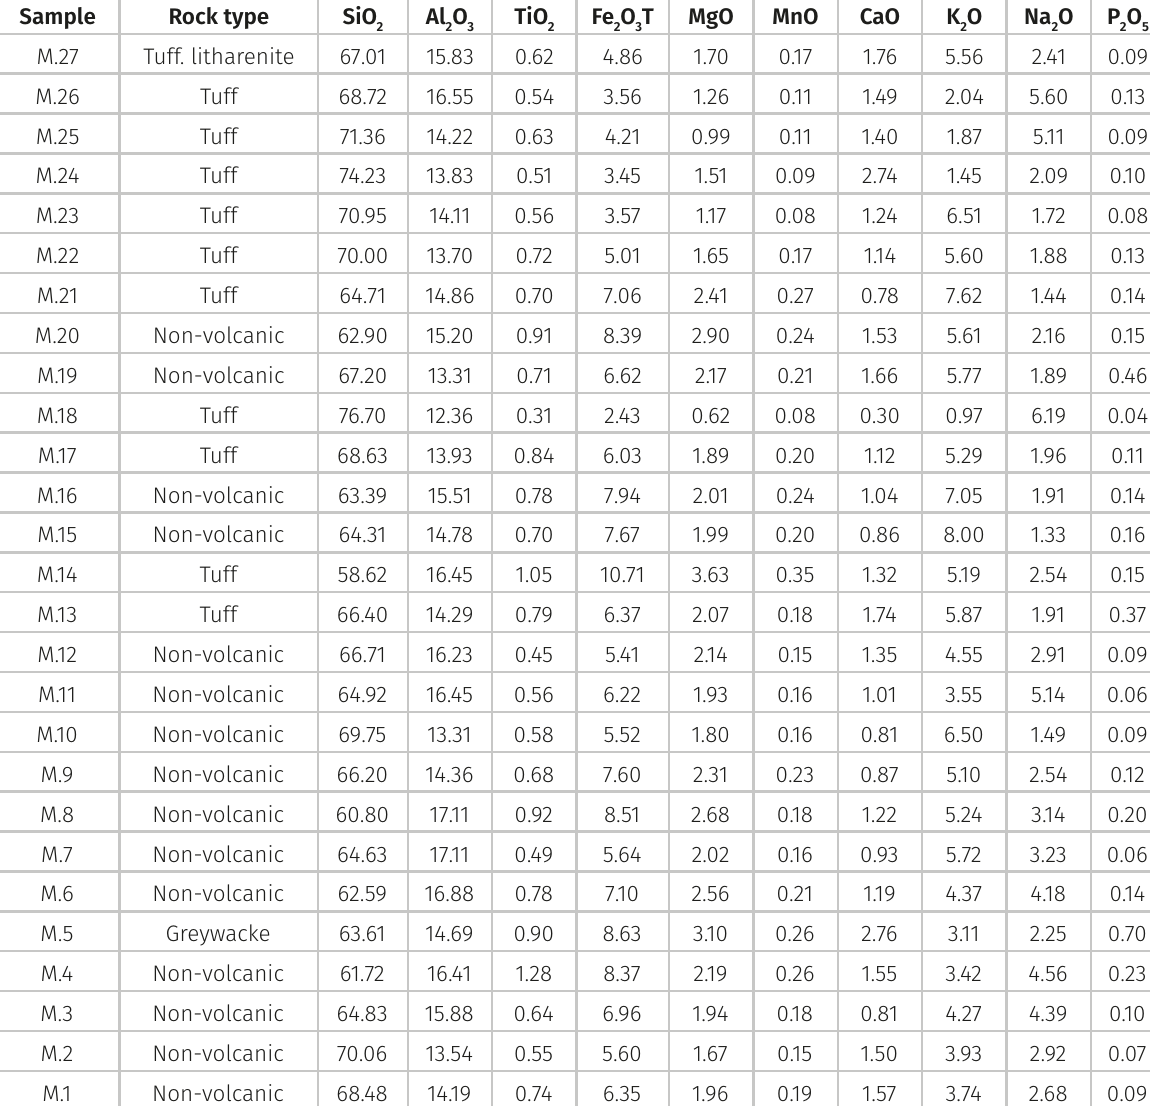
Table I. Bulk chemical composition of the primary volcaniclastic rocks from Cerro Negro Formation at the President Head Peninsula, Snow Island obtained by X-ray fluorescence (XRF). Major element compositions were recalculated on volatile-free basis and reported in weight percentage (wt.